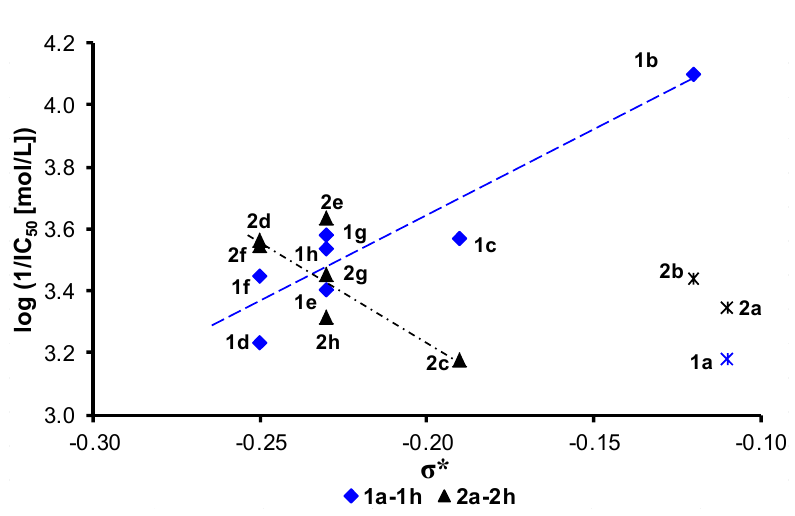
Figure 3. Dependence of PET-inhibiting activity log (1/IC 50 [mol/L]) of studied carbamates 1a – 1h and 2a – 2h on electronic properties expressed as Taft polar constants σ * of alkyl tail R 2 .